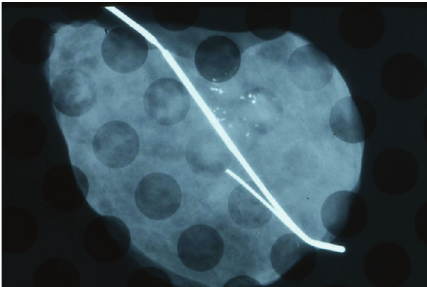
Figure 5: Specimen radiograph of a wire localization excission taken without compression. The cluster of abnormal calcifications is present but is not at the edge of the specimen. Often a second image is taken after rotating the specimen 90 degrees.